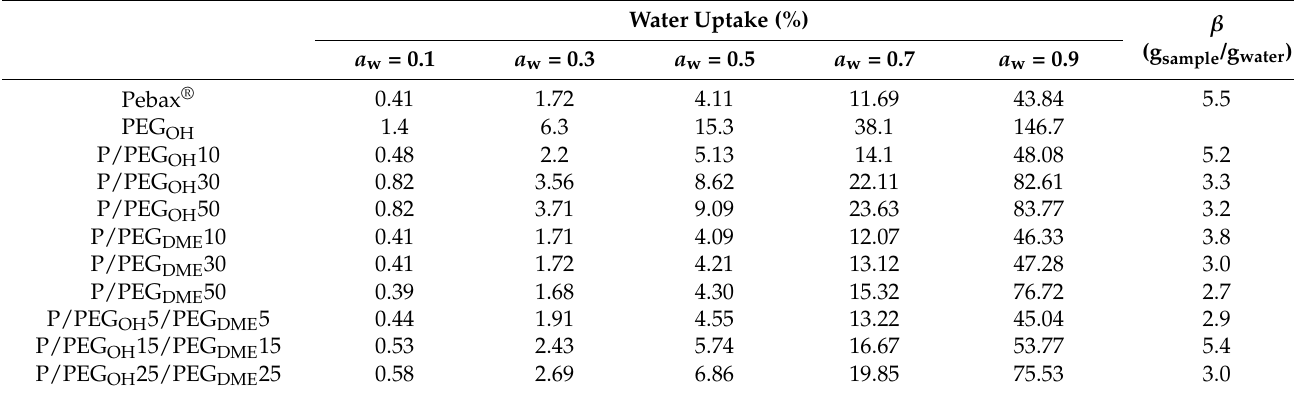
(g sample /g water ) a